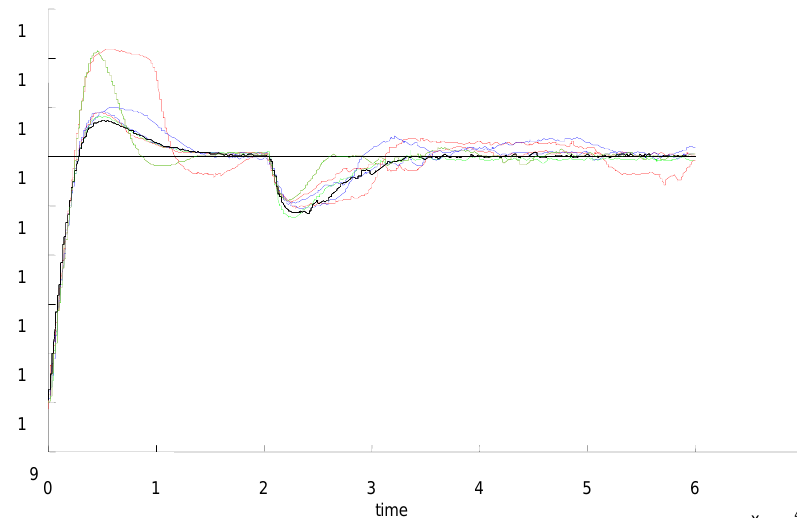
Figure 11. System responses of the time-based (black), hybrid (red), LC (blue), ILC (green) , LP (dashed red), ILP (dashed blue), EN (dashed green) with disturbance. 